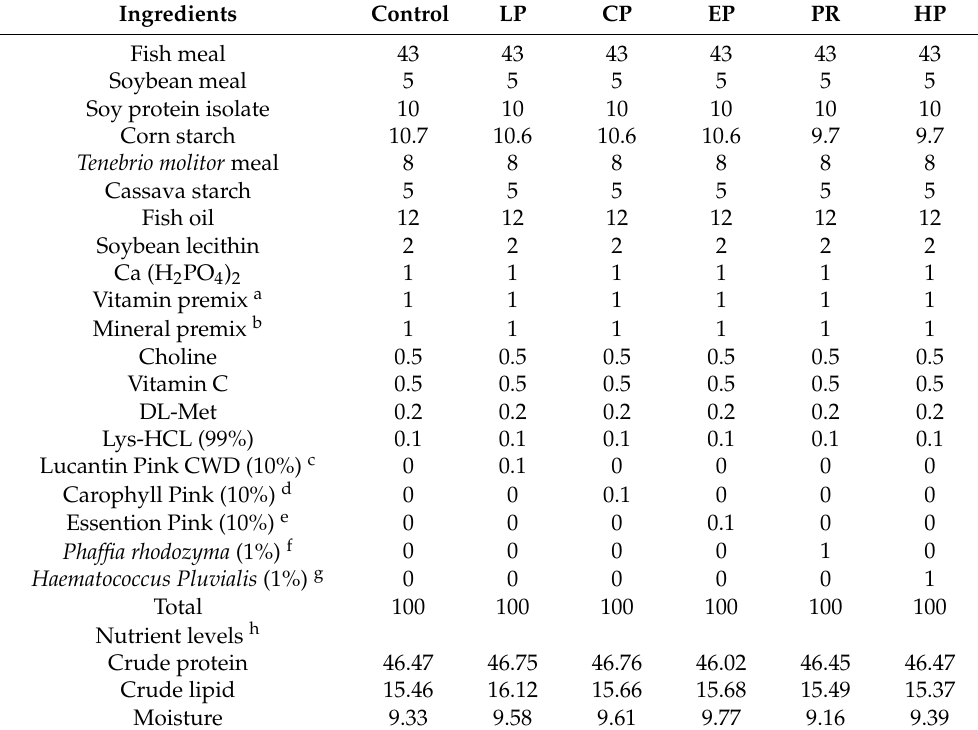
Table 1. Composition and nutrient levels of the experimental diets (% dry